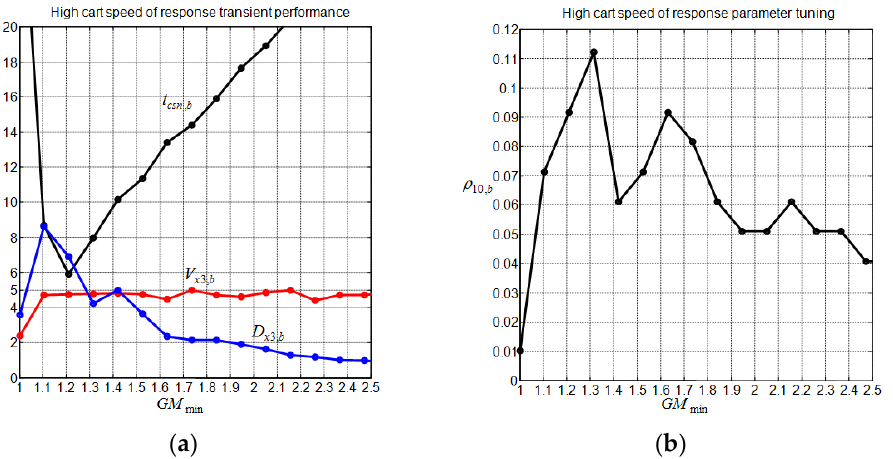
Figure 8. Impact of the gain margin on the cart transient of response. ( a ) Optimal cart control subsystem performance versus gain margin; ( b ) weight factor versus gain margin setting for high cart speed of response.